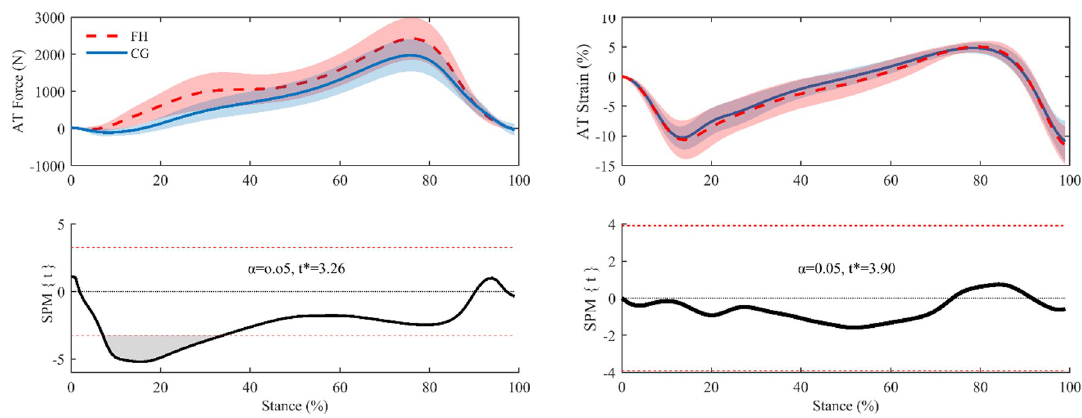
Fig 2. AT force (left) and AT strain (right) mean and standard deviation (top), and corresponding SPM analysis (bottom). Bottom left displays a supra-threshold cluster (grey area) between 8% and 34% of the stance phase, indicating a significant difference in AT force between groups and the critical threshold ( t � = 3.26) as a red dashed line ( p < 0.05). Bottom right shows no difference in AT strain between groups throughout the stance phase.